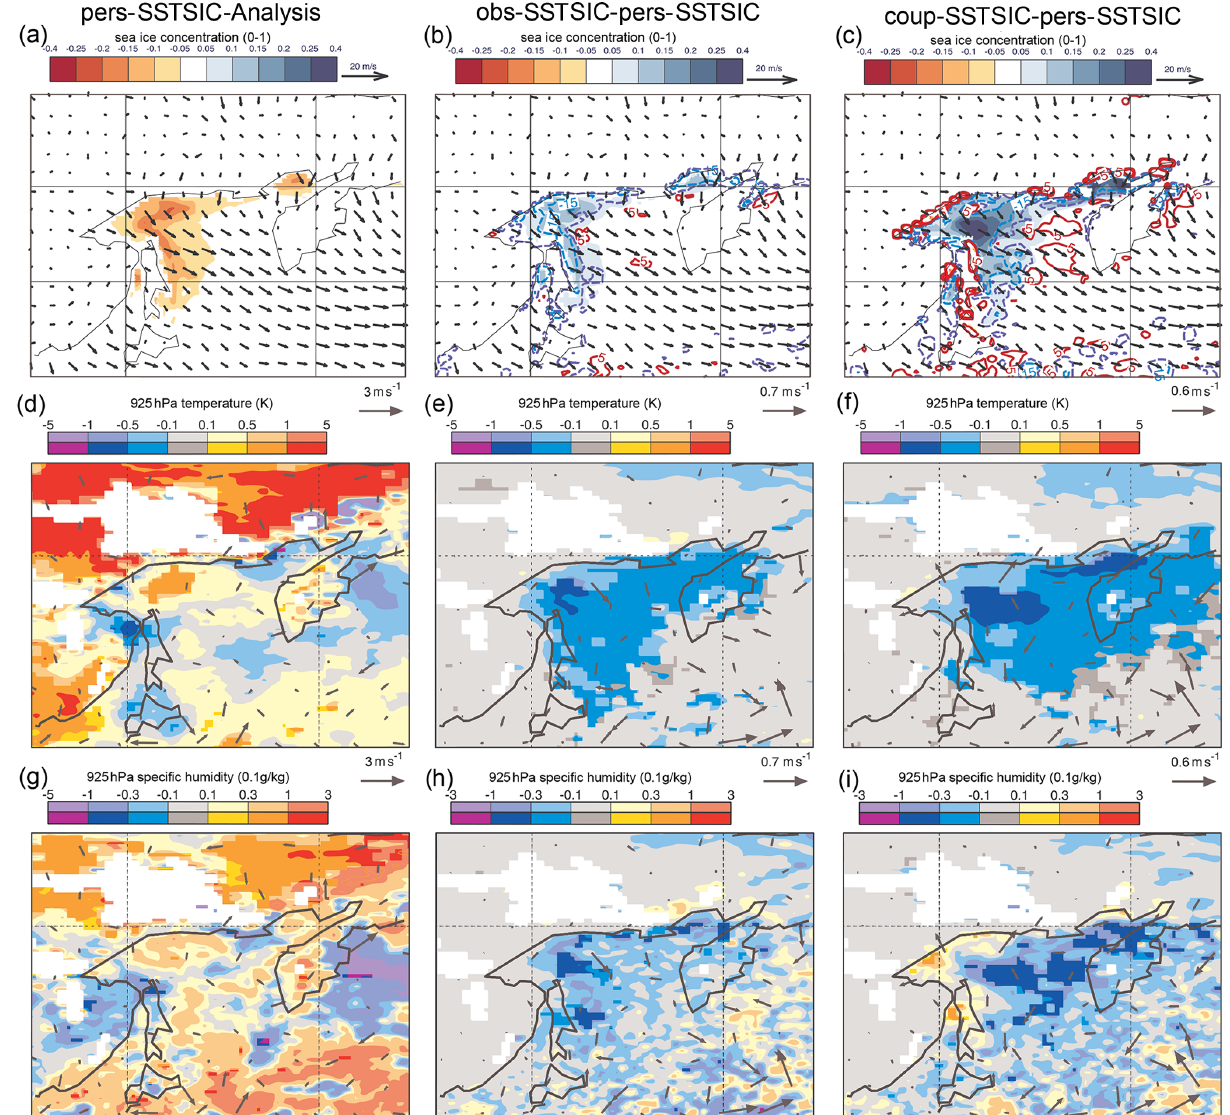
Figure 11. Composite of forecast error during periods of ice advance in the Sea of Okhotsk: day-3 sea ice concentration bias along with composite-mean winds at 925hPa (a) , T + 72 925hPa temperature and horizontal wind bias (d) , and specific humidity and horizontal wind bias (g) for the pers-SSTSIC forecasts and the change in the bias for obs-SSTSIC ( b , e and h ) and coup-SSTSIC ( c , f and i ). The change in the turbulent heat flux (sensible + latent accumulated between T + 48 and T + 72) is shown in the blue and red contours in (b) and (c) (anomalies are positive downwards). In panels (d–i) , saturated colours indicate mean differences that are statistically significant at the 5%